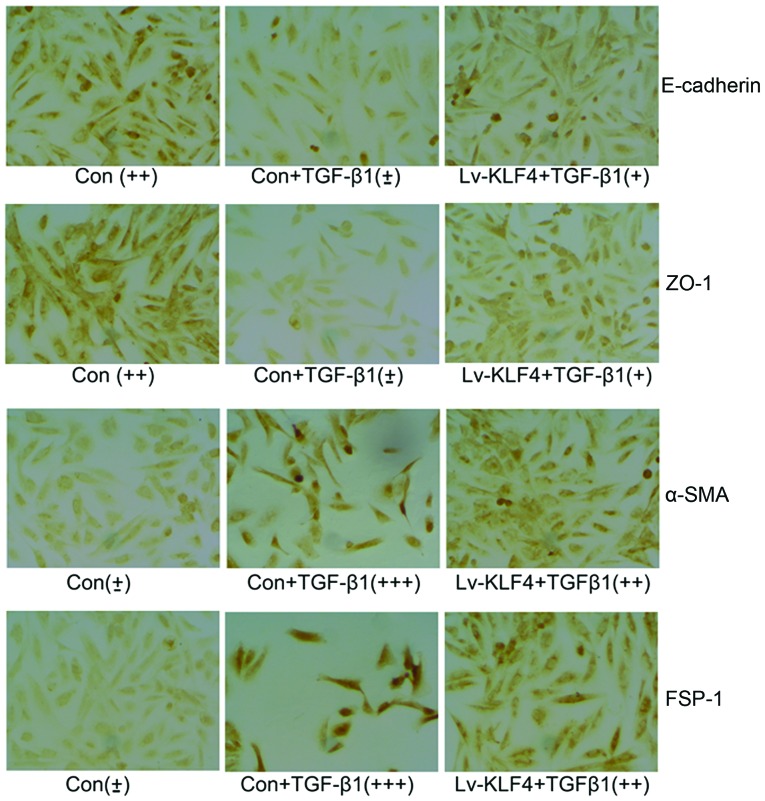
Immunocytochemical staining showing the expression of epithelial-to-mesenchymal transition (EMT) markers. E-cadherin, zonula occludens-l (ZO-1), α-smooth muscle actin (α-SMA) and fibroblast-specific protein 1 (FSP-1) in HK-2 cells treated with TGF-β1 or Lv-KLF4 + TGF-β1 using the antibodies respective. Protein expression was graded on a scale of ‘±’ to ‘+++’.